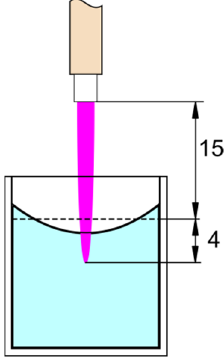
Figure 3. Experimental setup for chemical and biological treatment. The plasma jet impinges on the liquid surface and slightly dives into the liquid.